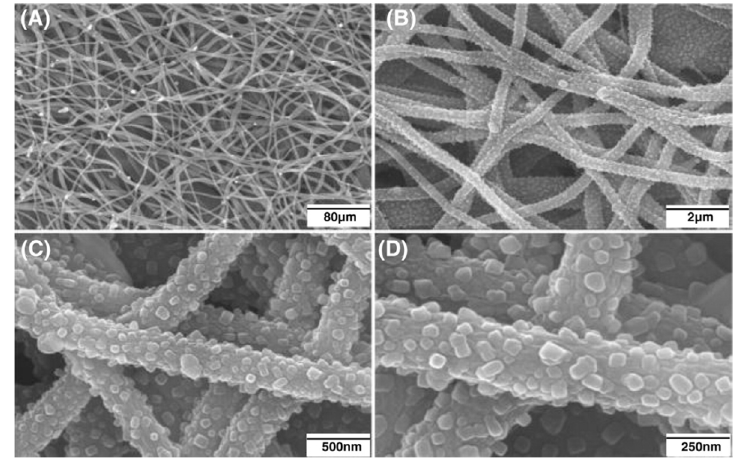
Figure 7. SEM photos of the distribution of well-dispersed β -TCP nanoparticles that firmly adhered to CNFs at various magnifications ( A ) 80 μ m, ( B ) 2 μ m, ( C ) 500 nm, ( D ) 250 nm. (Whereas the CNFs had an average diameter of about 300 nm, the average size of the β -TCP particles ranged from 30 to 60 nm). Reproduced with permission from Ref. [110].